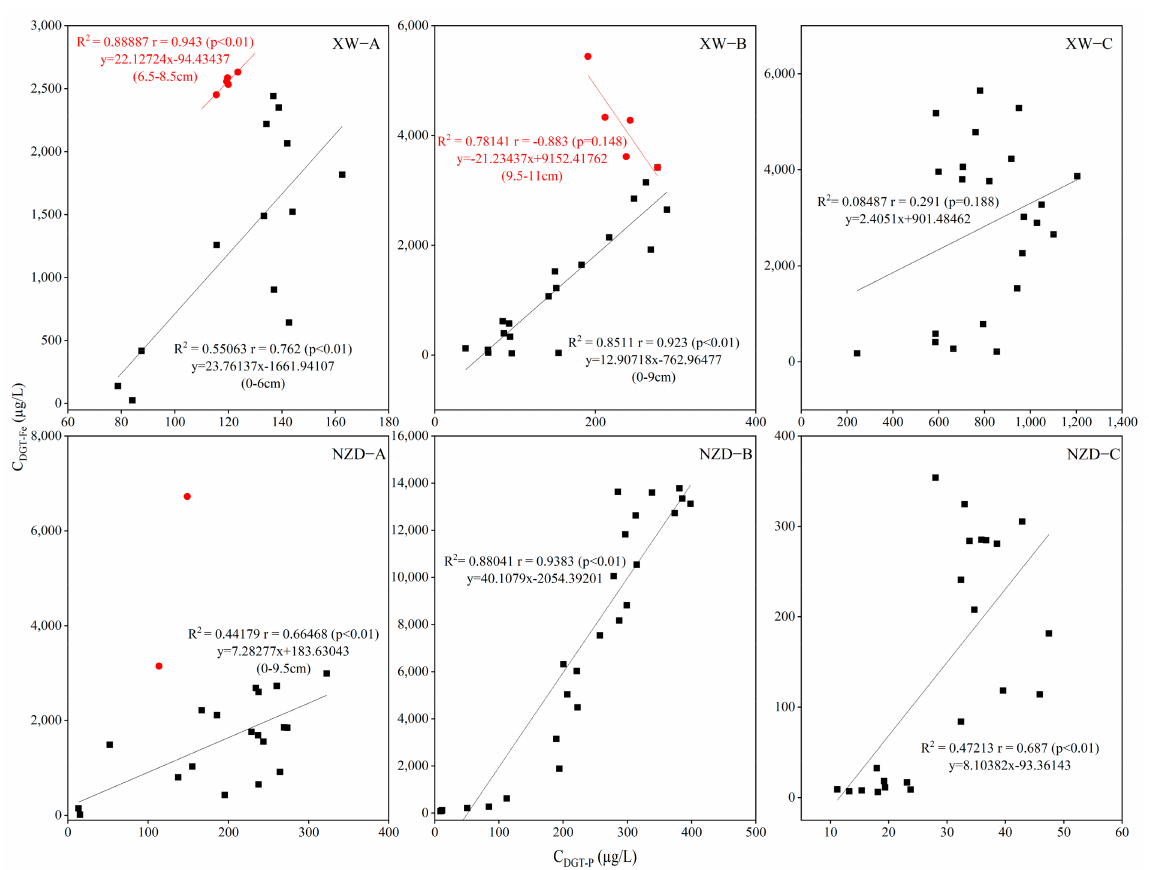
Figure 6. Linear regression analysis for the C DGT-P and C DGT-Fe in the